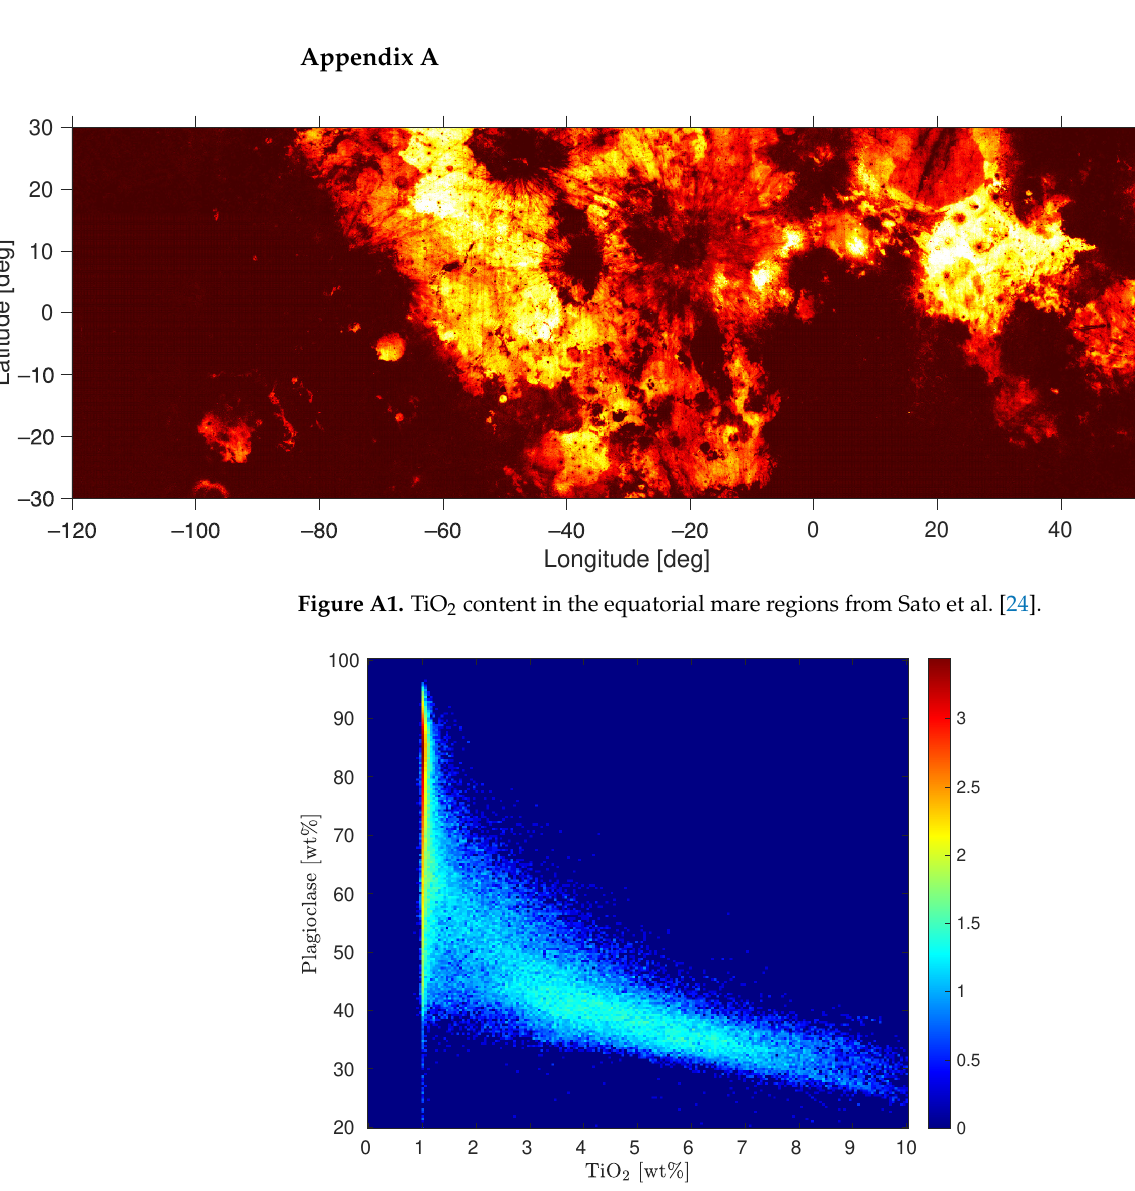
Figure A2. Density plot of plagioclase and TiO 2 abundance. The trend corresponds to a correlation coefficient of r = − 0.80. The color bar represents the decadal logarithm of the number of examples at a discrete pixel in parameter space.